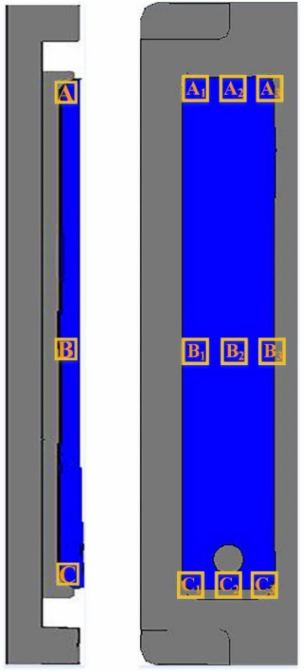
Figure 11. Shape deviation of a final glass device.